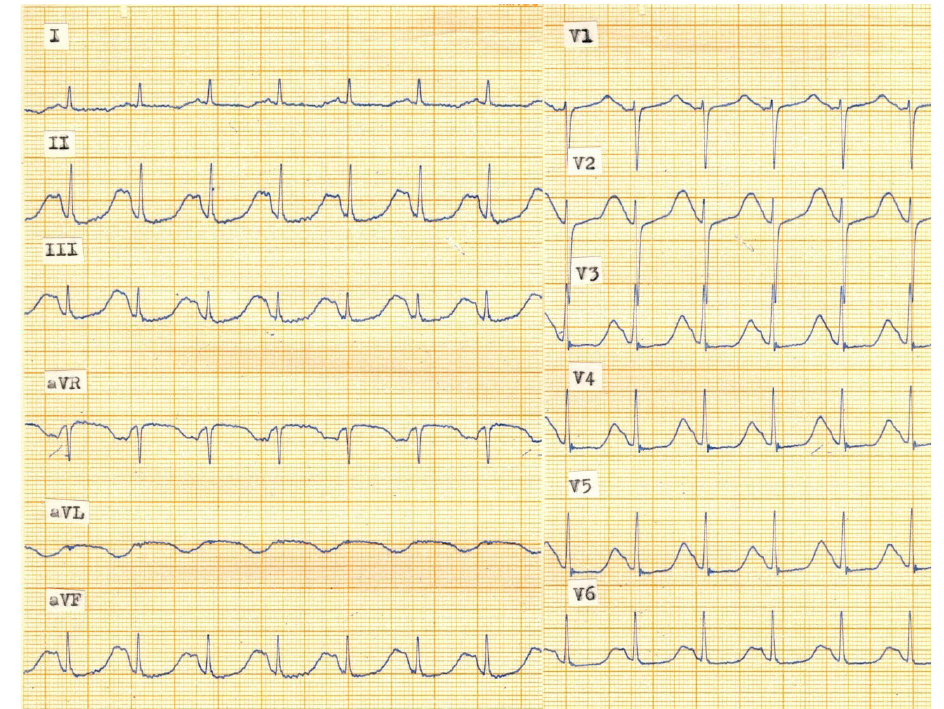
Fig. 1. Long QT syndrome (published with the permission of ass.professor Čestmír Čihalík).